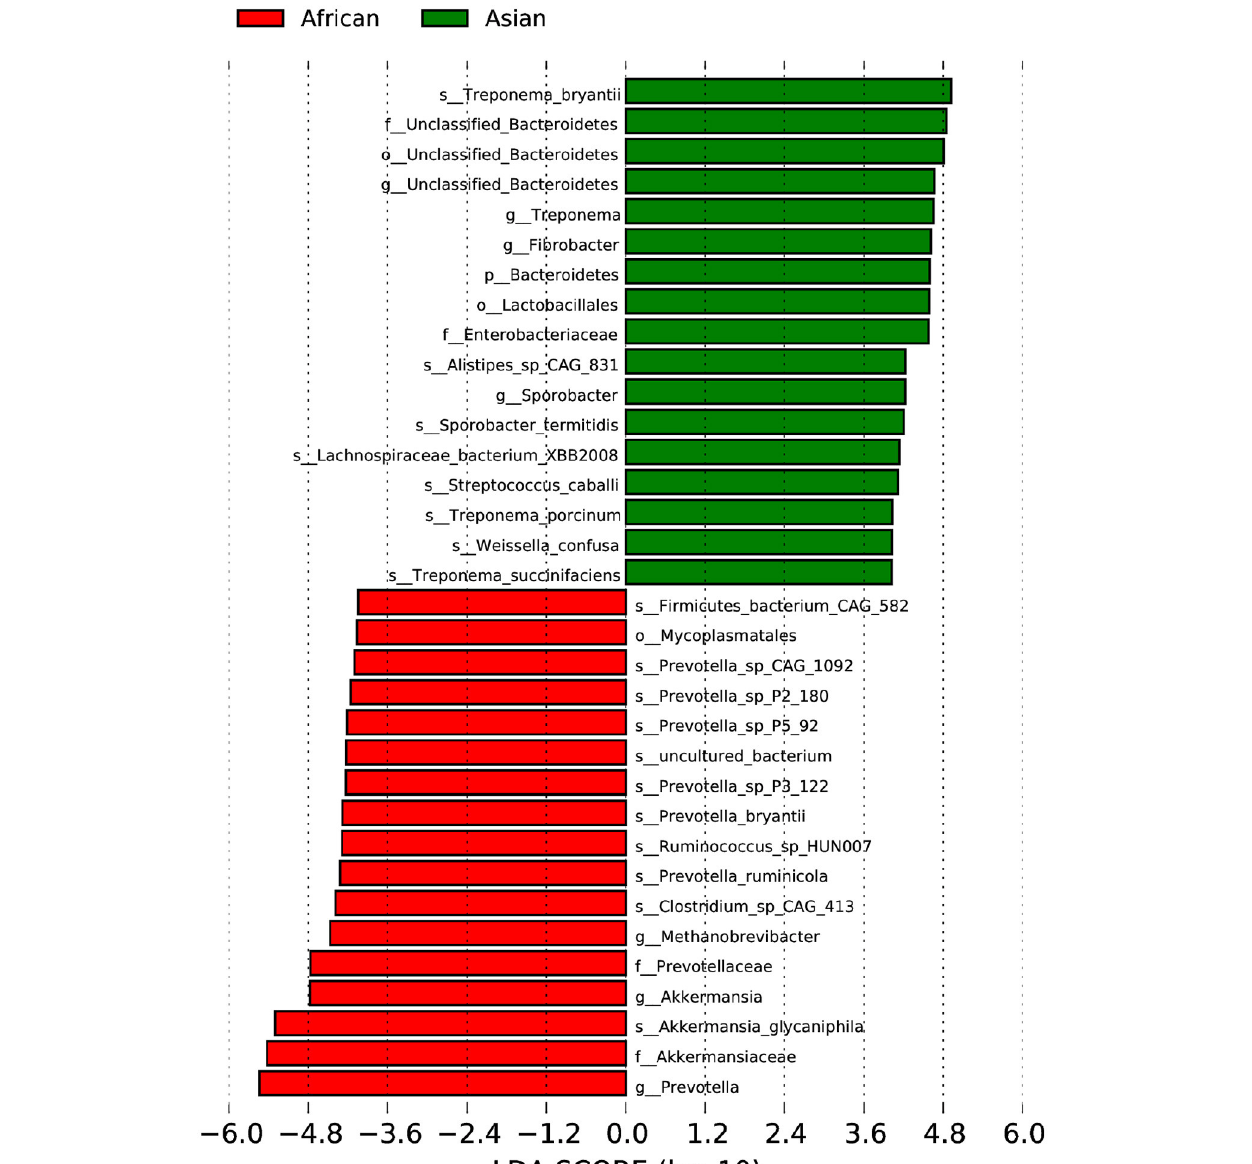
functions at level 1 of CAZy database were not significantly different between the two host species ( R 2 = 0.13, P = 0.47). The clustering tree based on Bray-Curtis distance showed that samples from African and Asian elephants formed two clusters (Figure